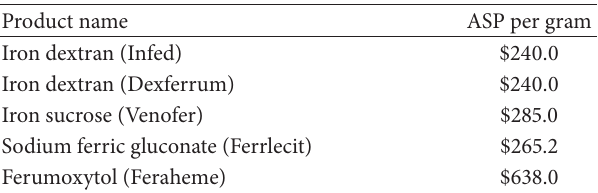
Table 4: Average selling price (ASP) based on Centers for Medicaid and Medicare